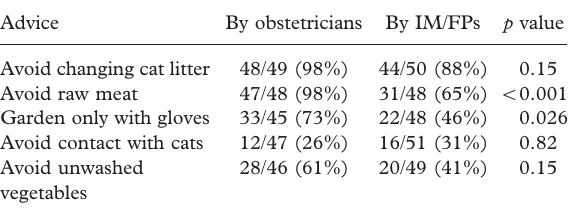
Table II. Advice aimed at primary prevention of